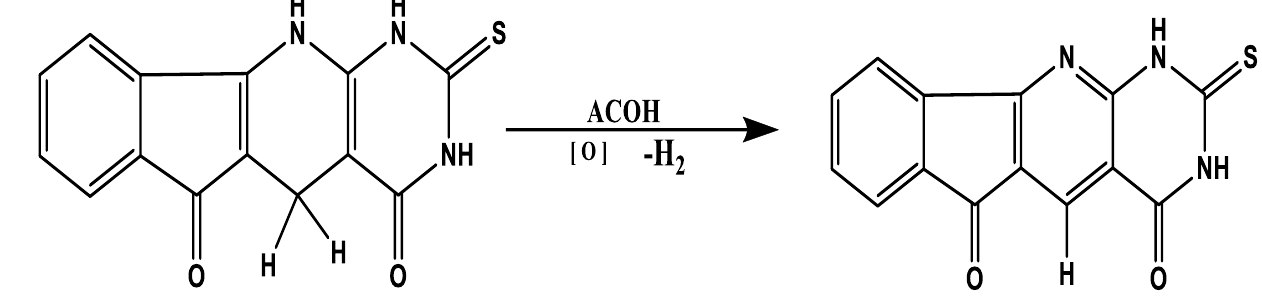
Figure 1. The oxidation of the 1H form of TUDHIPP to 1O.